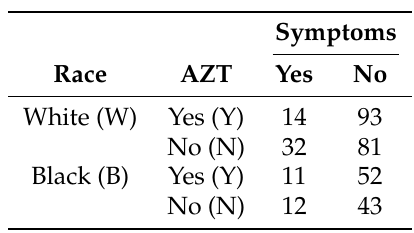
Table 7. Counts on the presence or absence of symptoms among AIDS patients who are on the antiretroviral drug AZT, categorized by